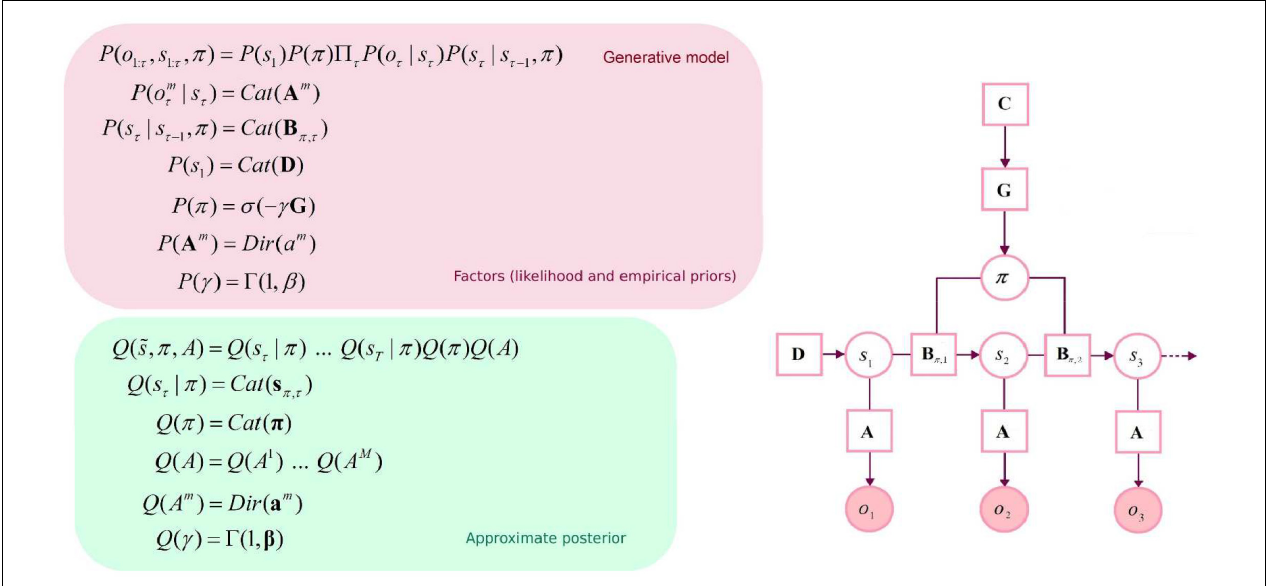
FIGURE 1 | Graphical depiction of the generative model and approximate posterior. This discrete-state space temporal model has one hidden state factor: location . This factor generates outcomes in two outcome modalities: where and what (with two levels: reward or null). The likelihood A is a matrix whose elements are the probability of an outcome under every combination of hidden states. B represents probabilistic transitions among hidden states. Prior preferences over outcome modalities for each hidden state factor are denoted by C. The vector D specifies priors over initial states. Cat denotes a categorical probability distribution. Dir denotes a Dirichlet distribution (the conjugate prior of the Cat distribution). An approximate posterior distribution is needed to invert the model in variational Bayes (i.e., estimating hidden states and other variables that cause observable outcomes). This formulation uses a mean-field approximation for posterior beliefs at different time points, for different policies and parameters. Bold variables represent expectations about hidden states (in italic). Transparent circles represent random variables, and shaded circles denote observable outcomes. Squares denote model parameters and expected free